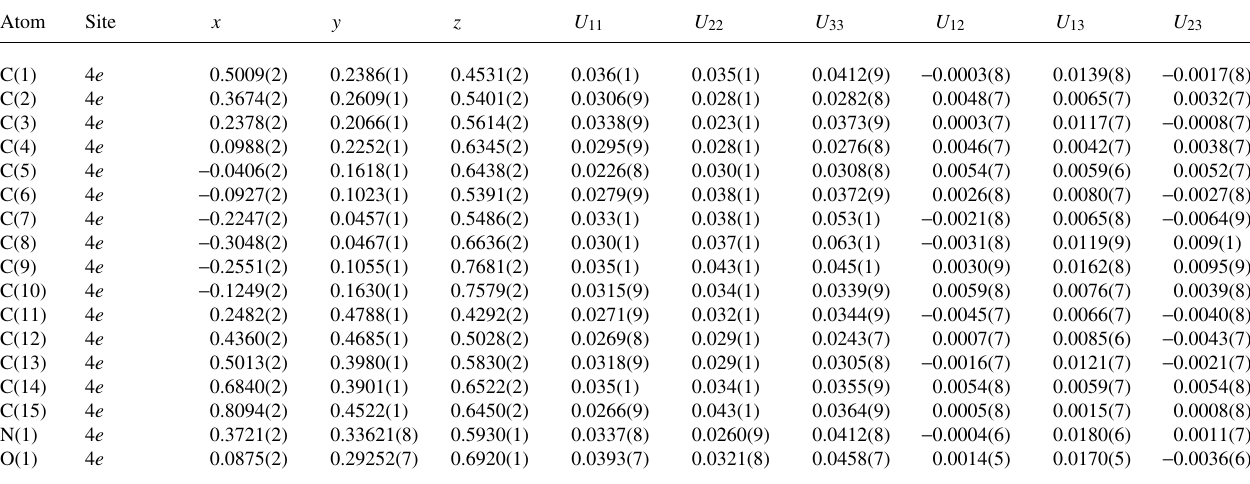
Table 3. Atomic coordinates and displacement parameters (in Å 2 )